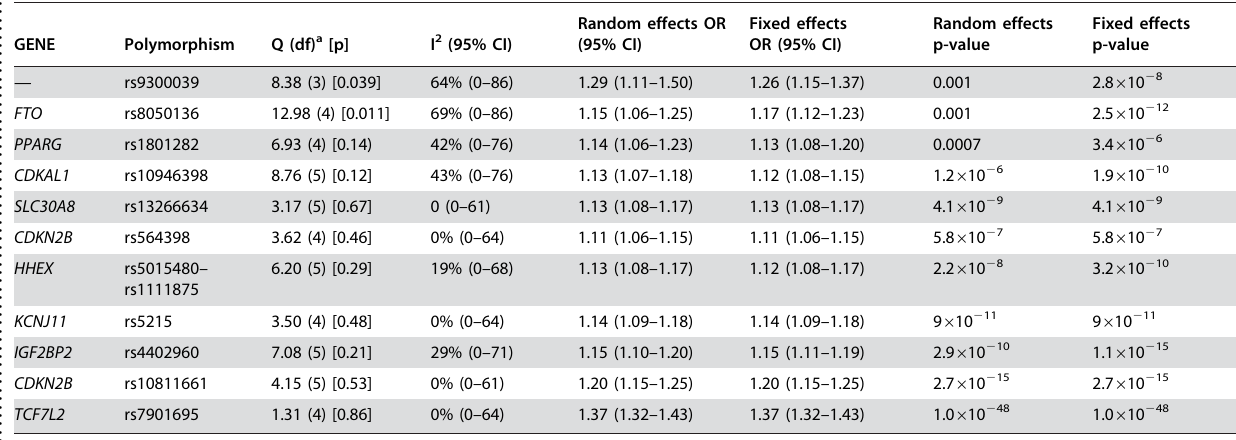
Table 2. Between-study heterogeneity and random versus fixed effects calculations for polymorphisms that were considered ‘‘confirmed’’ in sensitivity analyses considering the discovery and replication data of each GWA as a separate study.